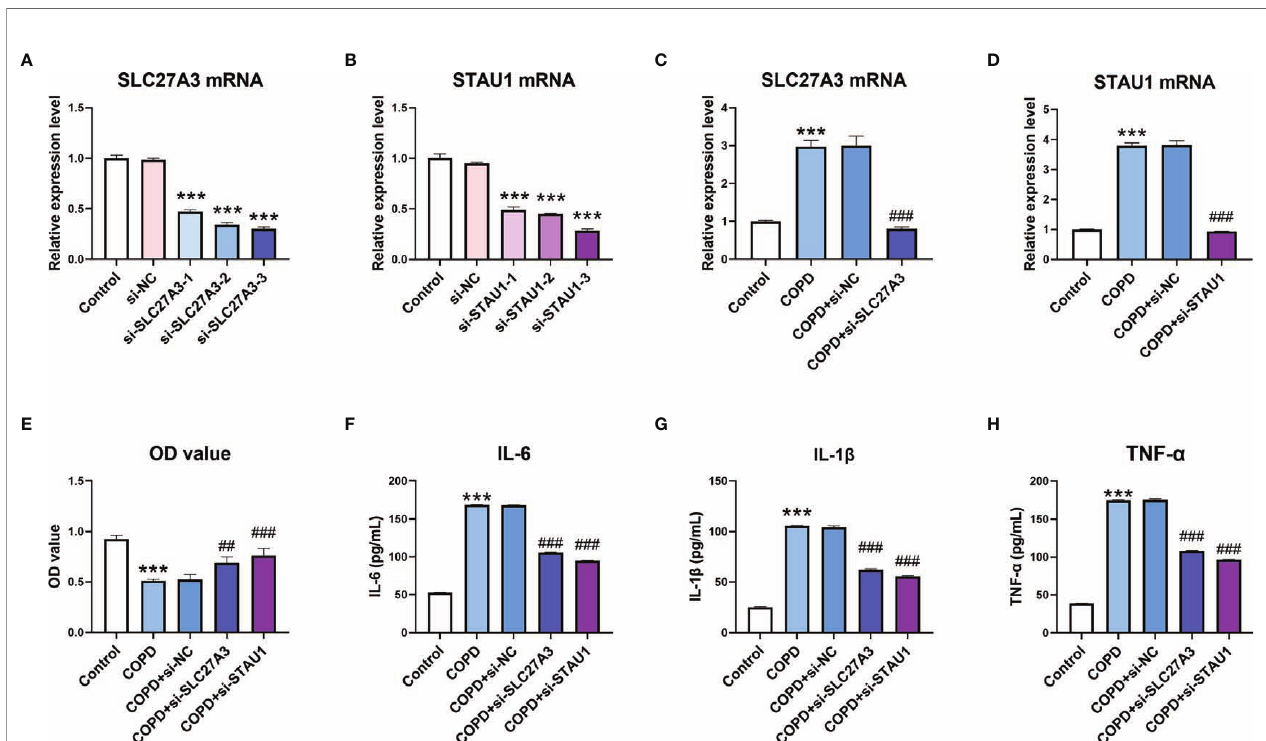
FIGURE 10 | Knockdown of SLC27A3 and STAU1 reversed the effect of cigarette smoke extract (CSE) on BEAS-2B cells. (A) The effect of si-SLC27A3 on SLC27A3 mRNA expression in BEAS-2B cells. (B) The effect of si-STAU1 on SLC27A3 mRNA expression in BEAS-2B cells. (C) The expression of SLC27A3 mRNA in CSE-treated BEAS-2B cells after knockdown of SLC27A3. (D) The expression of STAU1 mRNA in CSE-treated BEAS-2B cells after knockdown of STAU1. (E) The viability of CSE-treated BEAS-2B cells after knockdown of SLC27A3 or STAU1. (F) The expression of IL-6 in CSE-treated BEAS-2B cells after knockdown of SLC27A3 or STAU1. (G) The expression of IL-1 b in CSE-treated BEAS-2B cells after knockdown of SLC27A3 or STAU1. (H) The expression of TNF- a in CSE- treated BEAS-2B cells after knockdown of SLC27A3 or STAU1. For panel A and B, ***P < 0.001 vs. si-NC; for panel C-H, ***P < 0.001 vs. Control; ## P < 0.01, ### P < 0.001 vs.